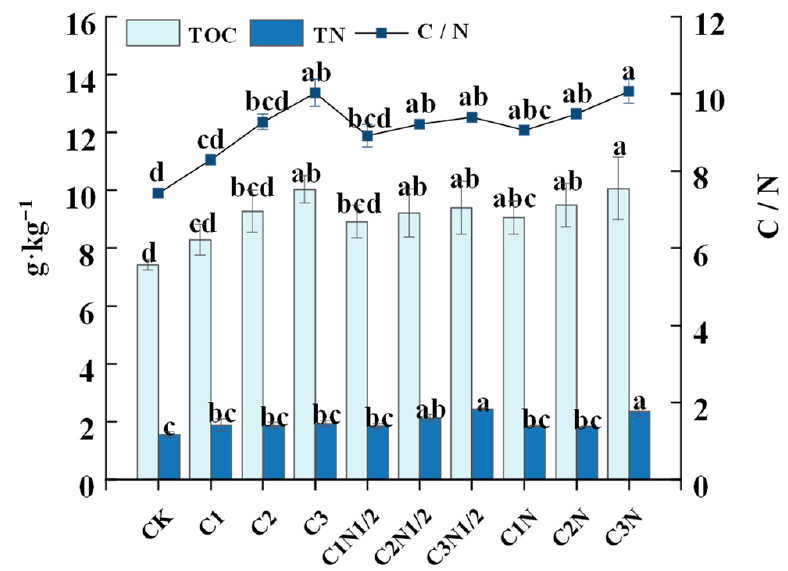
Figure 1. Total organic carbon (TOC), total nitrogen (TN), and carbon to nitrogen ratio (C/N) in black soils under different treatments. The bars reflect the mean standard deviation ( n = 3). Different letters above the bars show statistically significant ( p < 0.05) differences between the treatments.